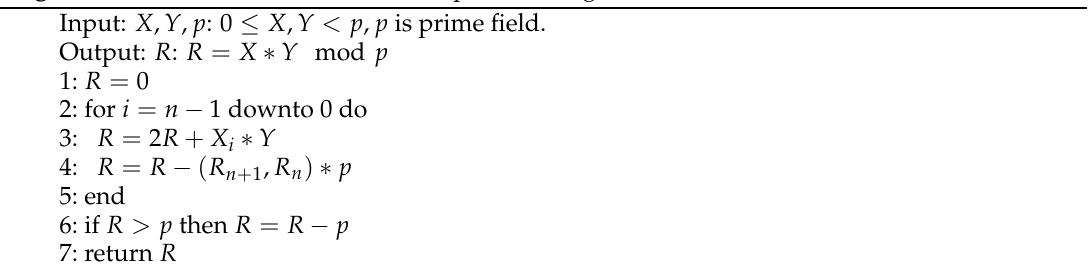
Algorithm 4: Interleaved Modular Multiplication